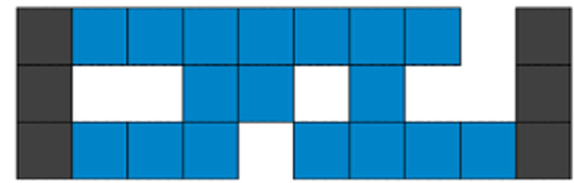
Fig. 2 All possible void element placement restrictions. The black voxels denote non-design regions where the boundary conditions are applied and then cannot be hollowed out. The blue voxels are material voxels (whether smart or inert